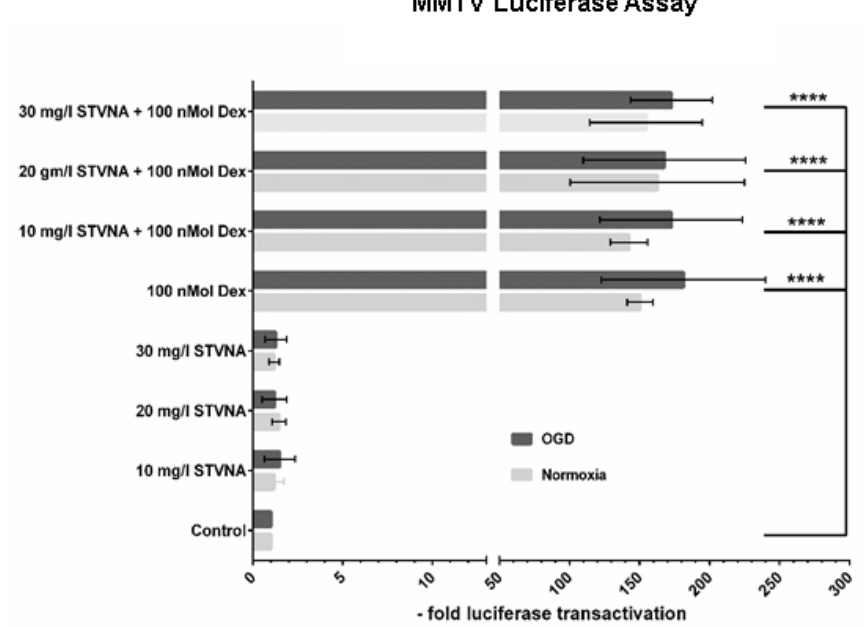
Figure 3. Glucocorticoid receptor (GR) activity remains the same after treatment with STVNA. Luciferase assay post-OGD, **** p ≤ 0.0001, n = 3.